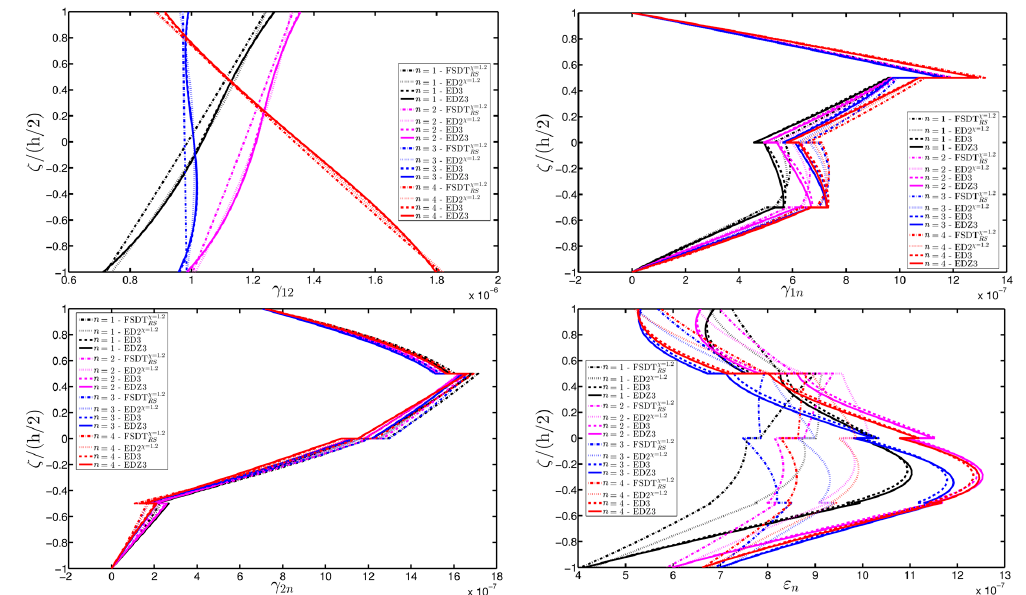
Figure 25. Through-the-thickness profiles of strain components for the CCCF doubly-curved panel of revolution computed at the point C for different HSDTs. The effect of the damage is investigated by varying the parameters of the function Gau-6.